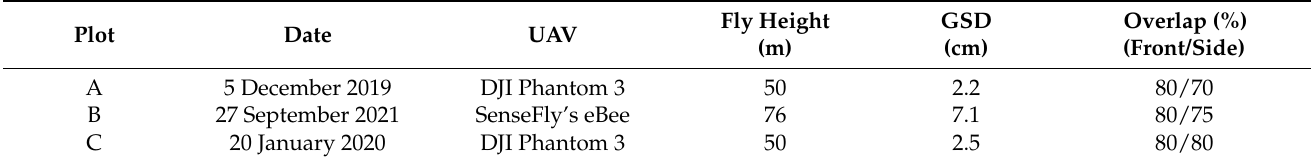
Table 1. Characteristics of the imaging flights of each studied plot.